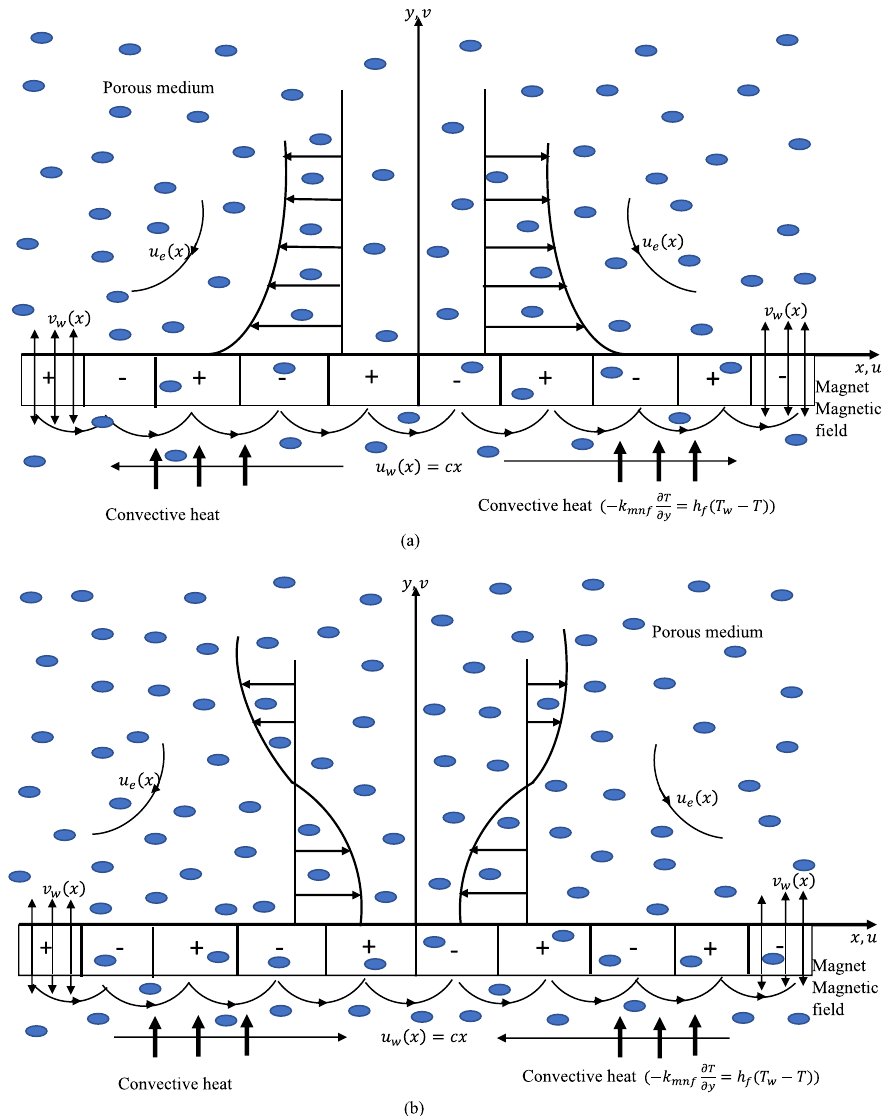
Figure 1: Geometry of the model. ( a ) Stretching surface, and ( b ) shrinking